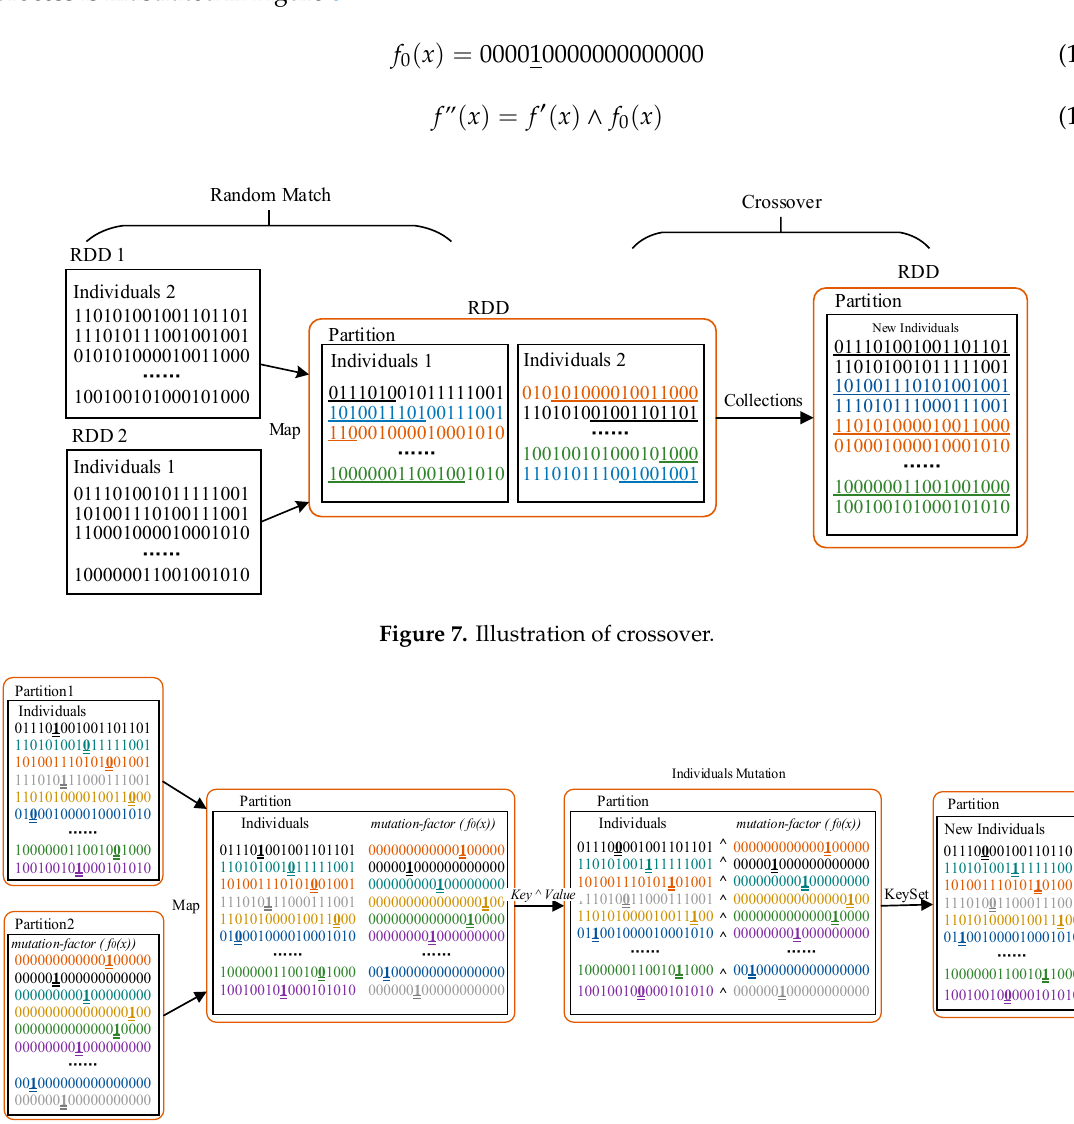
Figure 8. Illustration of mutation.